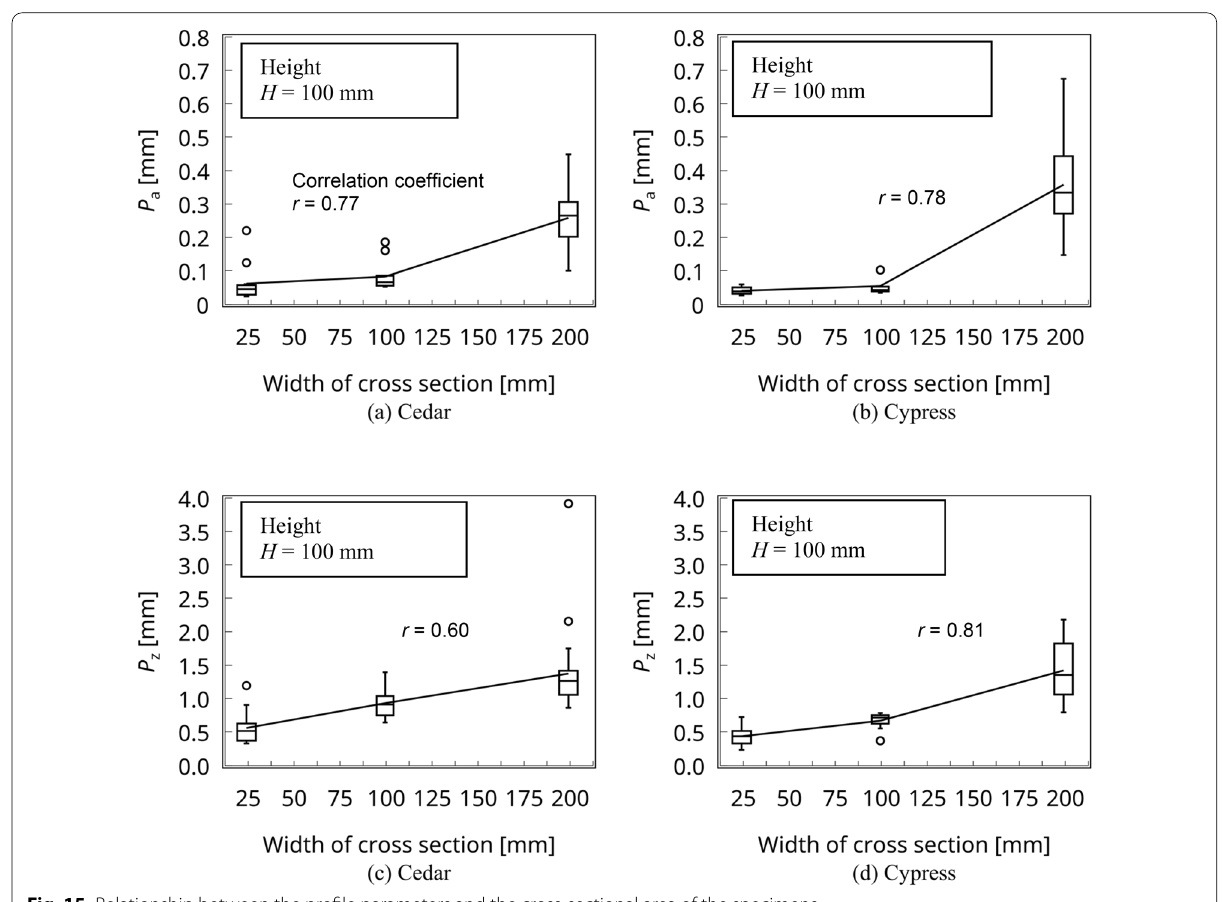
Fig. 15 Relationship between the profile parameters and the cross-sectional area of the